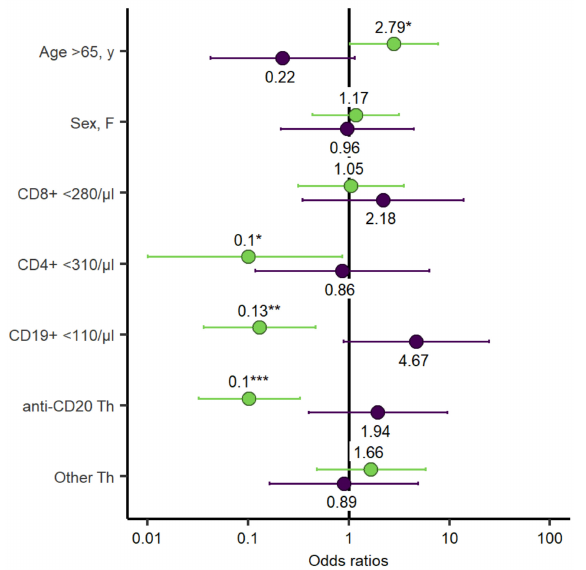
Figure 2. Odds ratio for univariate logistic regression assessing seroconversion and T-cell response. Each of the variables was tested individually against seroconversion (green bars) and T-cell response (purple bars) in all patients. p -values are specified as follows: <0.05, *; <0.01, **; <0.001, ***.